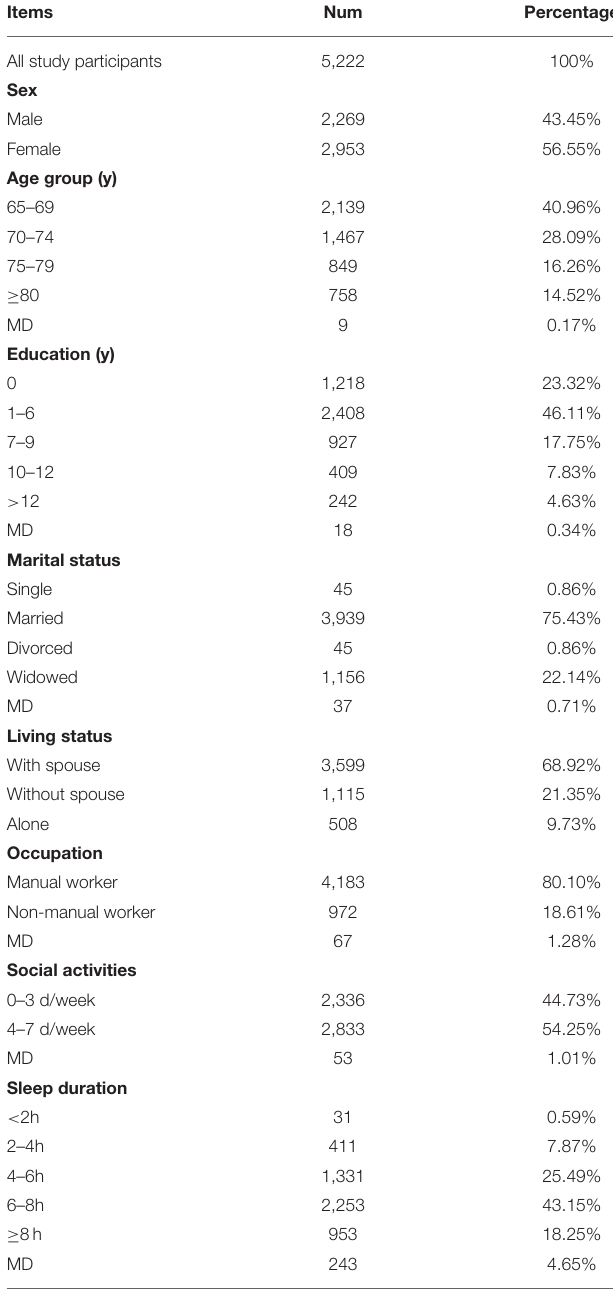
TABLE 1 | Demographic characteristics of the study